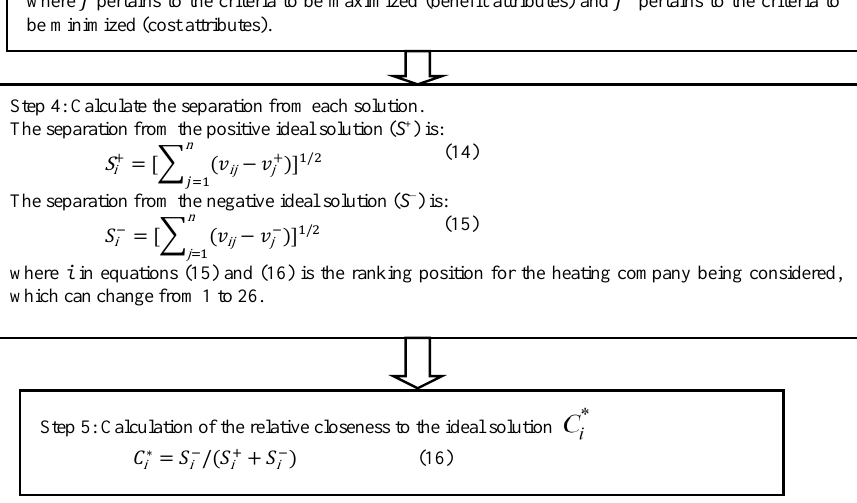
Fig. 3 Stepwise procedure for performing TOPSIS methodology